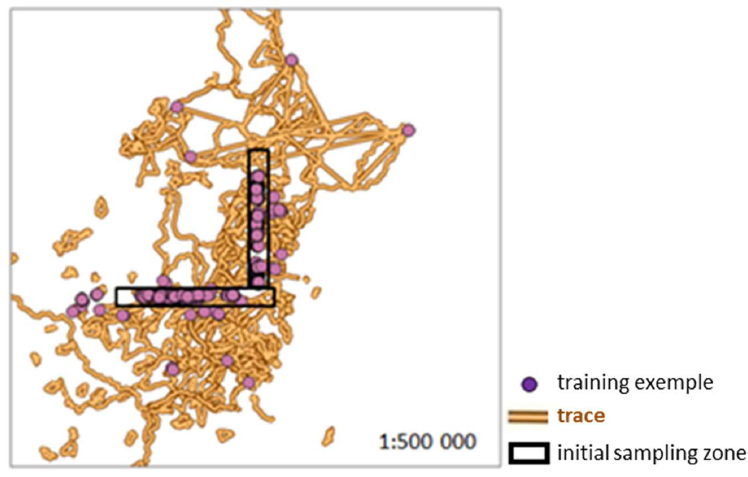
Figure 8. Training dataset for supervised machine learning.